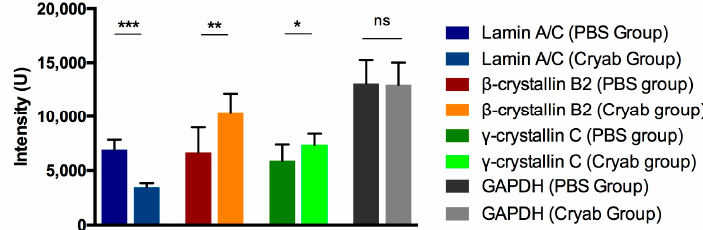
Figure 7. Antibody microarray detection of specifically altered retinal proteins. The protein regulations, detected in the MS measurements, could be validated with antibody microarray for lamin A/C, β -crystallin B2 and γ -crystallin C, using GAPDH for loading control purposes. Lamin A/C levels in the PBS group were significantly higher than in the crystallin-injected (cryab) group, while the levels of β -crystallin B2 and γ -crystallin C were found higher in the cryab group (* p < 0.05, ** p < 0.01, *** p < 0.001, ns—not significant, n = 9 per exp. group, mean ± SD, one-way ANOVA).